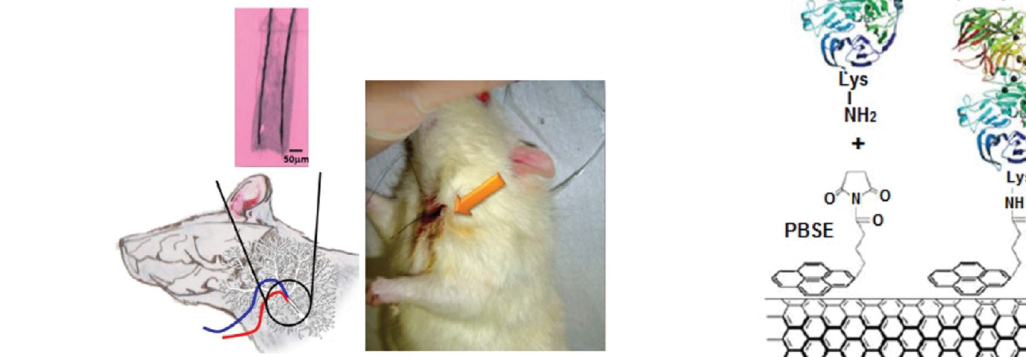
197 Nanochem Res 1(2): 183-204, Summer and Autumn 2016